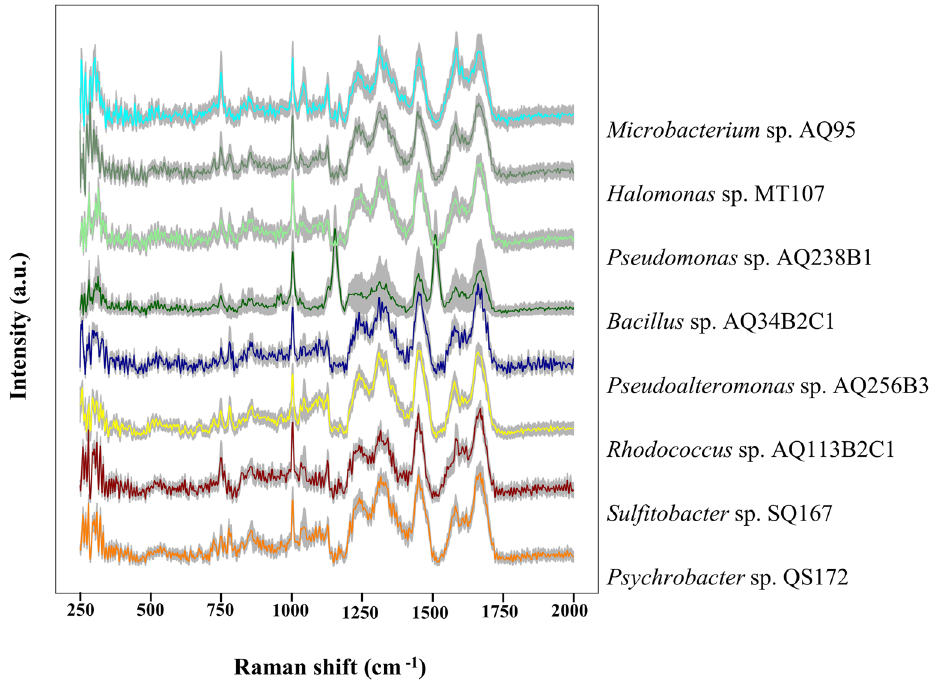
Figure 1. Raman spectra of eight cold seep microorganisms. Each strain has at least 500 spectra. The solid line represents the average value of Raman spectrum, and the standard deviation is represented by shadow.